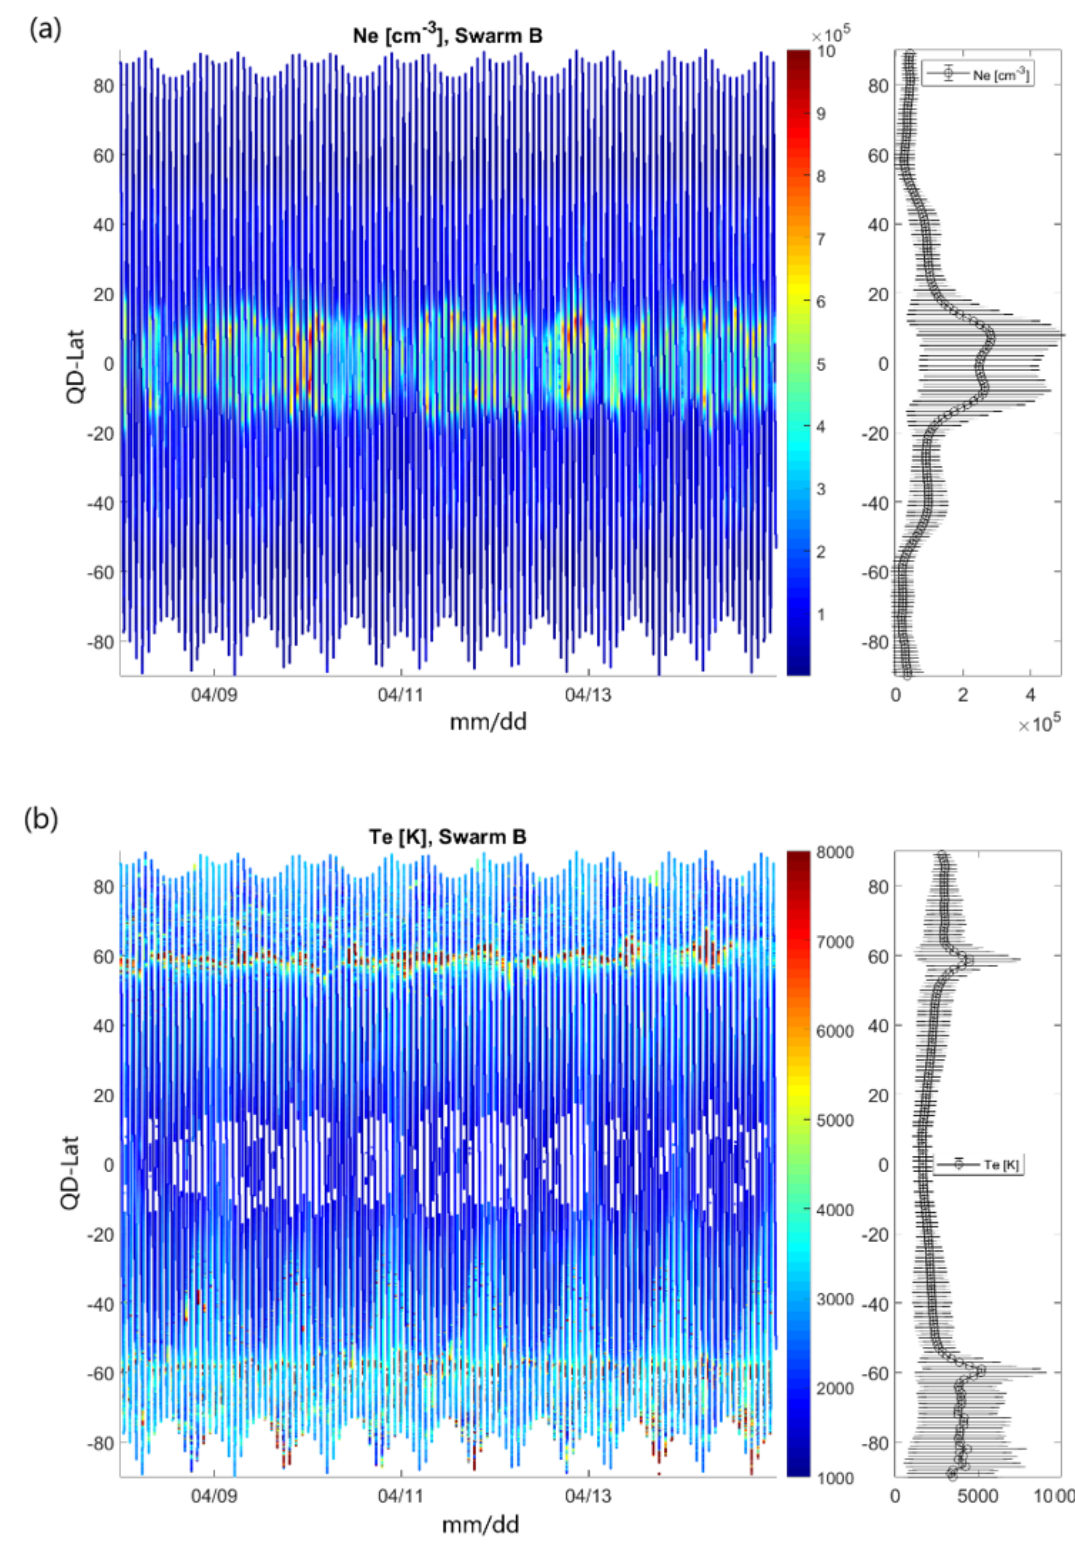
Figure 4. Plasma density (a) and electron temperature (b) measured aboard Swarm B between 8 and 15 March 2018, as a function of latitude in quasi-dipole coordinate and time. The vertical lateral panel shows the average (squares) and standard deviation (vertical bars) for each degree in latitude. During this period, the spacecraft was performing a noon–midnight